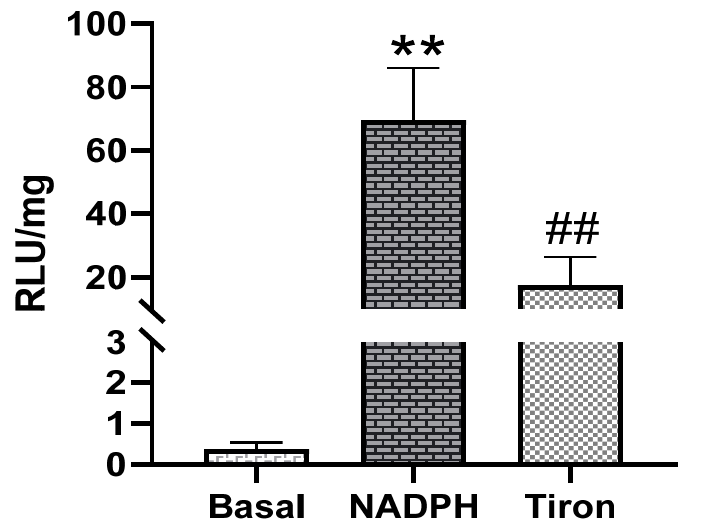
Figure 4. Superoxide production measured by lucigenin-enhanced luminescence in PMC tissue. Note: high levels of superoxide production stimulated by NADPH ** p < 0.01 vs. basal; ## p < 0.01 vs. NADPH, n = 21.